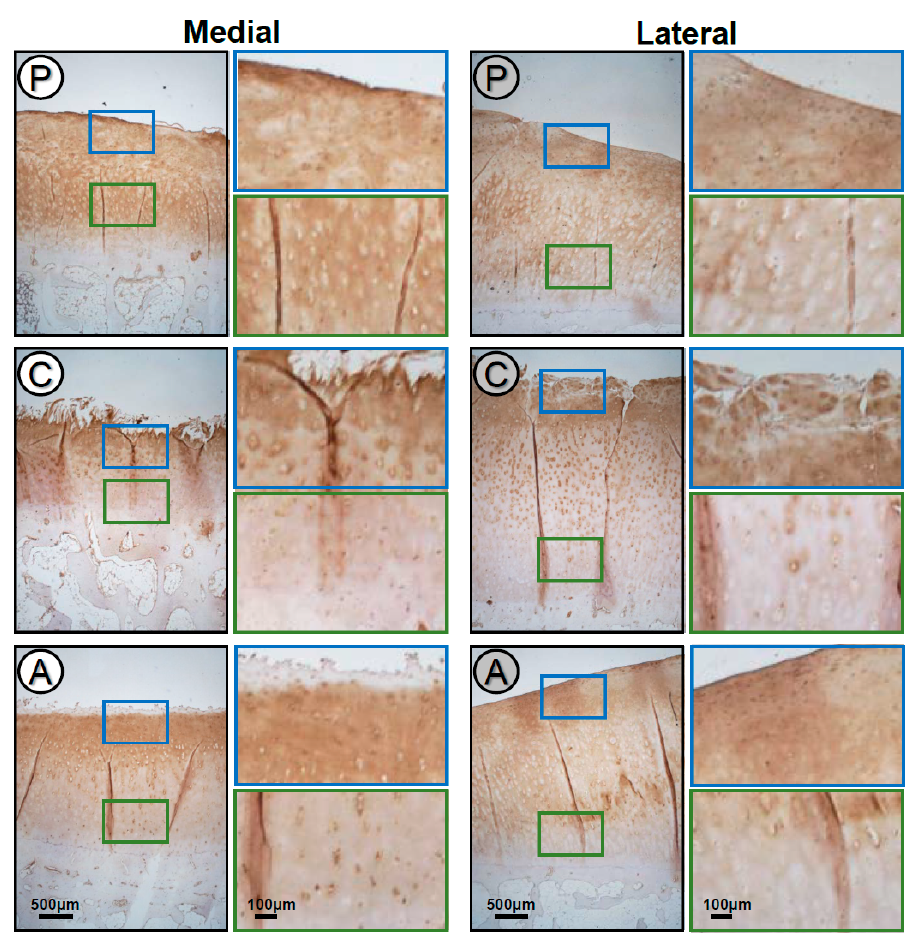
Figure 2. Localization of COMP in the different articular cartilage subregions (A: anterior, C: central, P: posterior) of the medial and lateral tibial compartments. Magnifications of the upper (blue) and deep (green) zone of the subregions. The anterior and posterior subregions of both the medial and lateral compartments showed an almost identical COMP staining pattern, whereas in the central subregion of the lateral compartment, a re-expression of COMP could be detected in the upper zone. Representative COMP-stained sections of the different subregions ( n = 12).